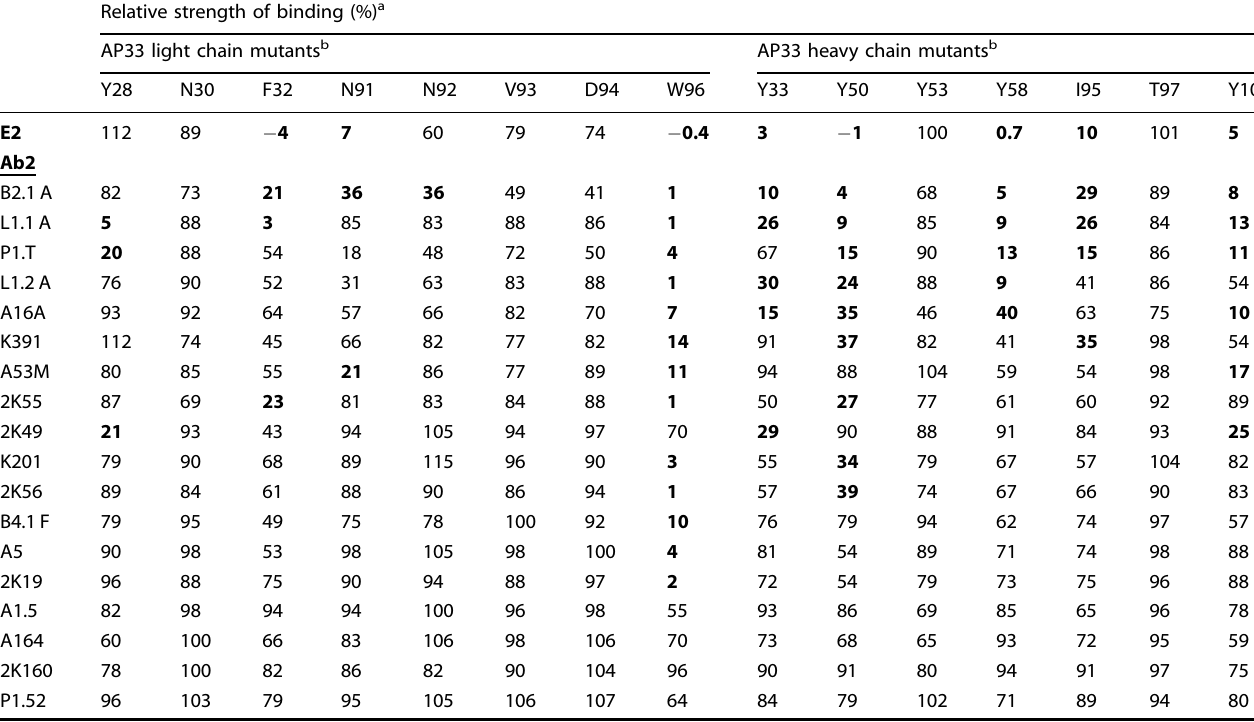
Table 1. Binding properties of E2 and of Ab2 antibodies to wild type and mutant AP33. Relative strength of binding (%) a AP33 light chain mutants b